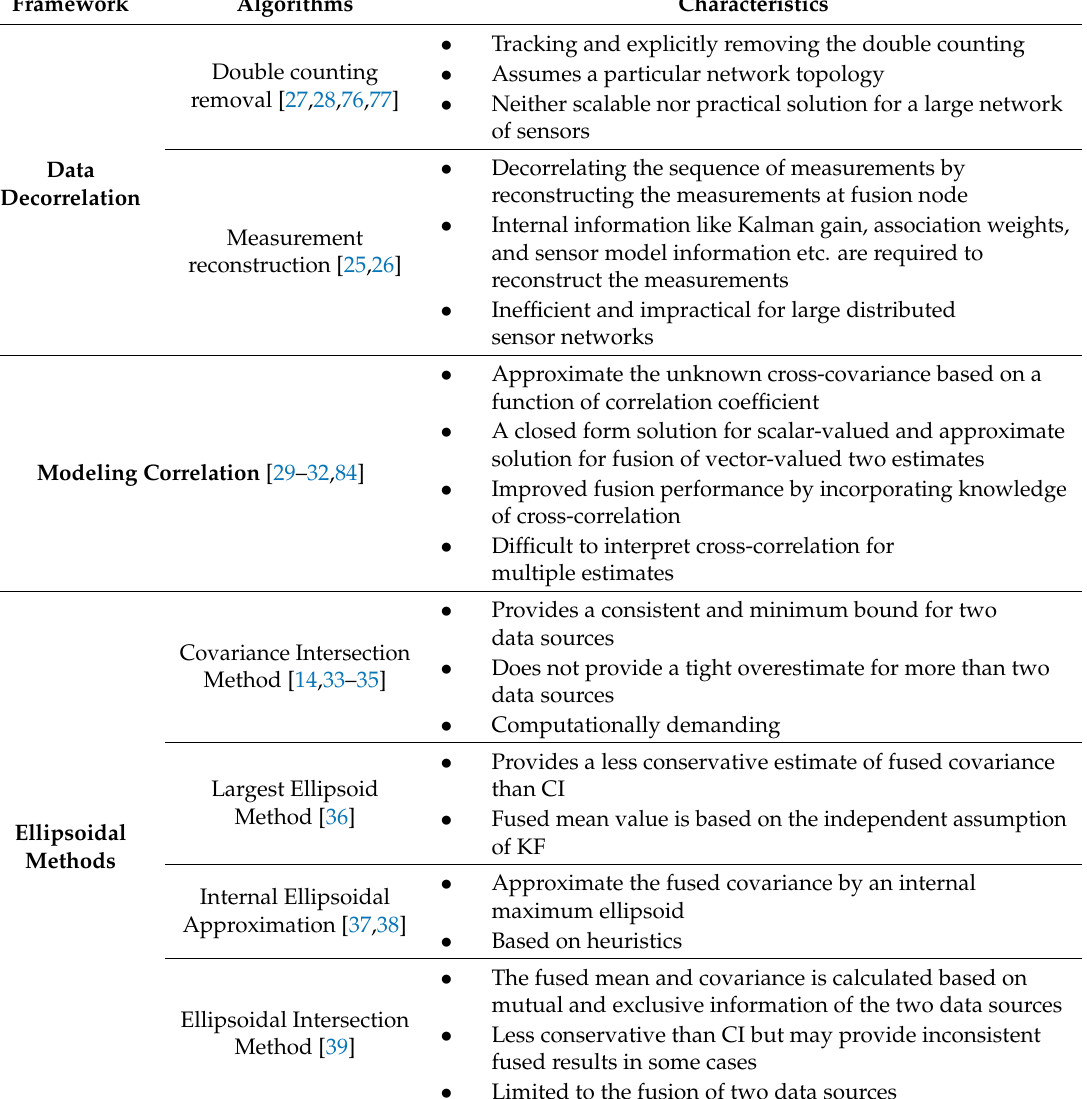
Table 2. Summary of various algorithms for fusion under unknown